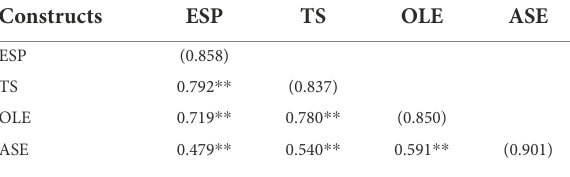
TABLE 3 Discriminant validity for the measurement model.